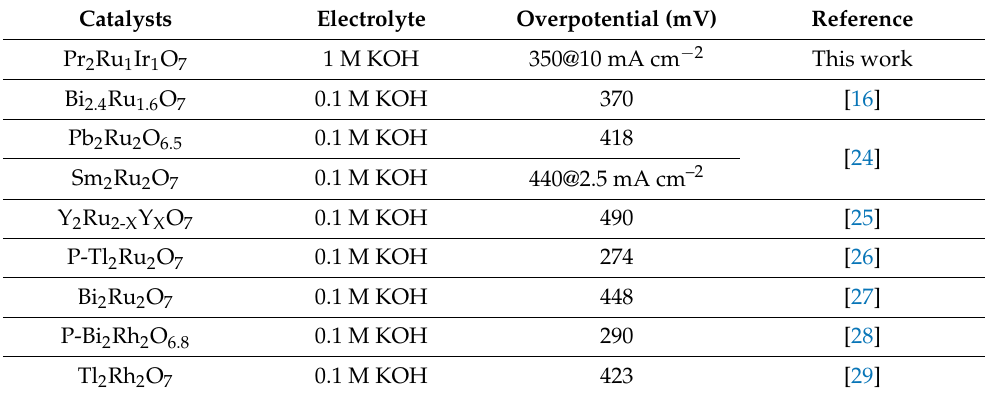
Table 1. A comparison of some representative pyrochlore OER catalysts reported under alkaline conditions. Catalysts Electrolyte Overpotential (mV)